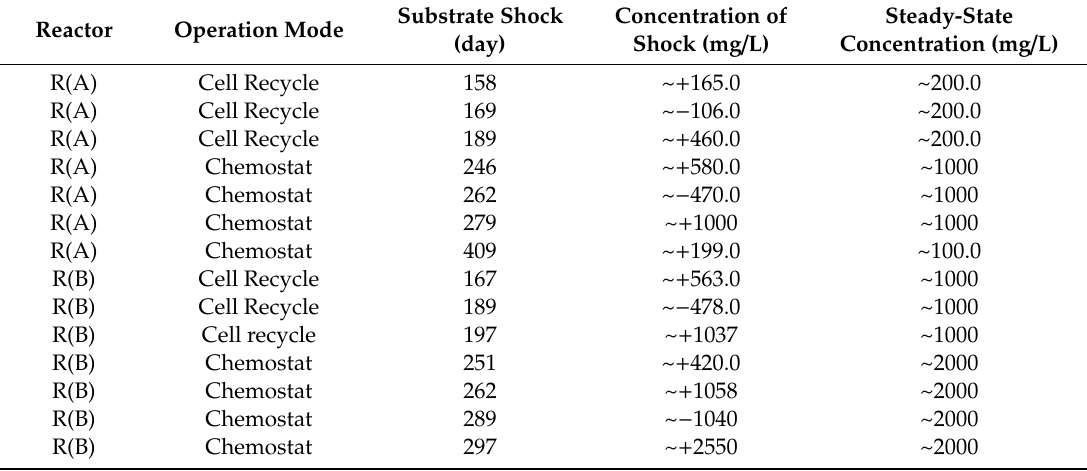
Table 3. Substrate shocks and recovery at various steady-state